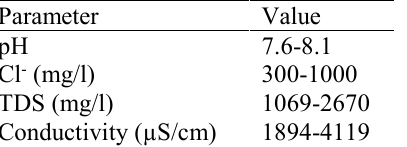
Table 1. Characteristics of thickener over flow